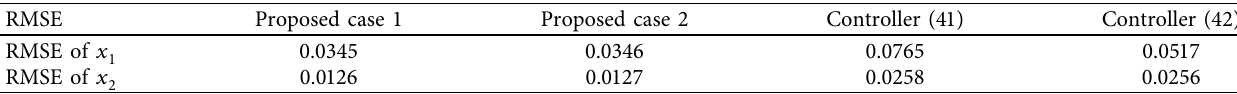
Table 1: RMSE values of proposed methods and other